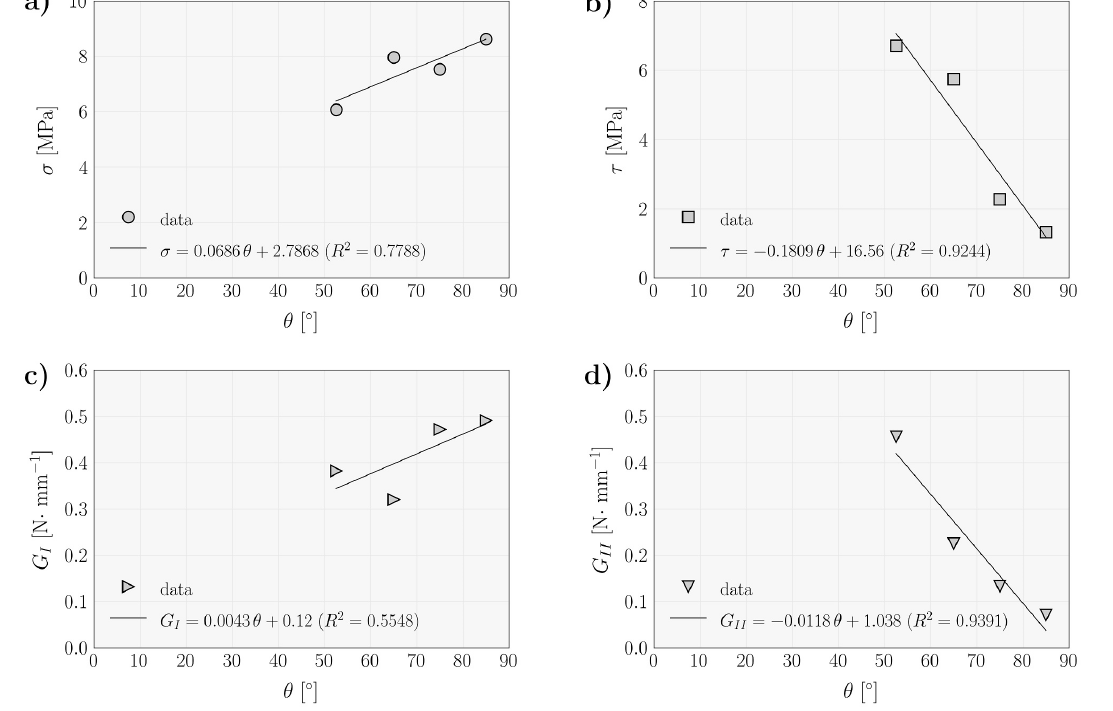
Figure 7. Evolution of cohesive law parameters as a function of global phase angle ( a ) ultimate normal stress; ( b ) ultimate shear stress; ( c ) mode I strain energy component; and ( d ) mode II strain energy component.